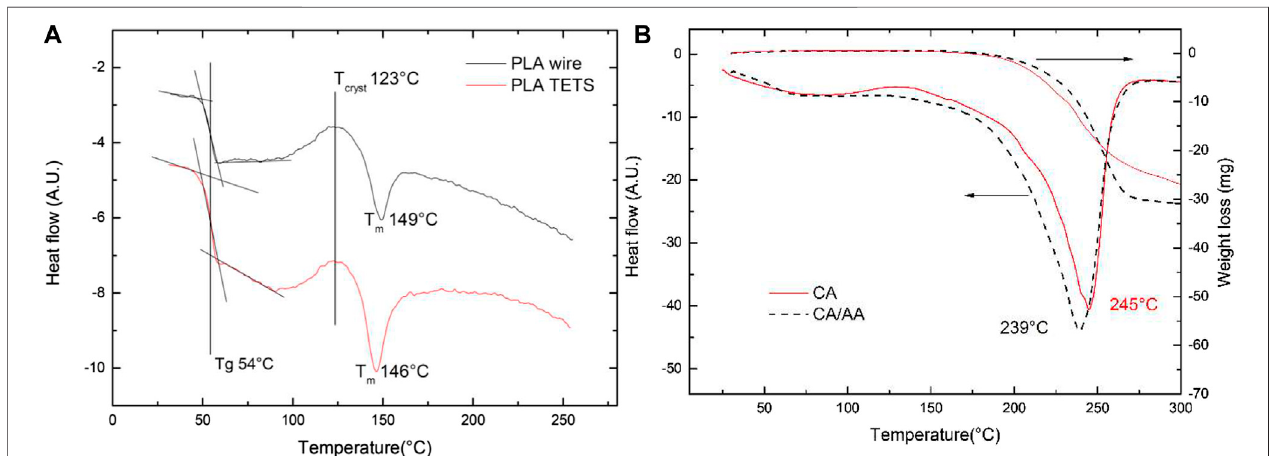
FIGURE 6 | Comparison of the DSC of PLA employed in the making of the TETS. Run Conditions N2 fl ow 100 ml min-1, temperature ramp 10 ° C min-1 (A) Comparison of the DSC-TGA of the polymerized CA and CA/AA adhesives after a week of curing in air. Run Conditions N2 fl ow 100 ml min-1, temperature ramp 10 ° C min-1 (B)